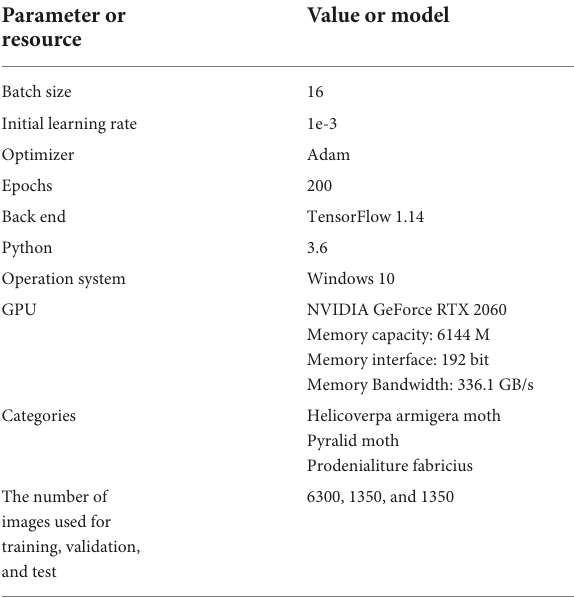
TABLE 1 Parameters and resources used in training